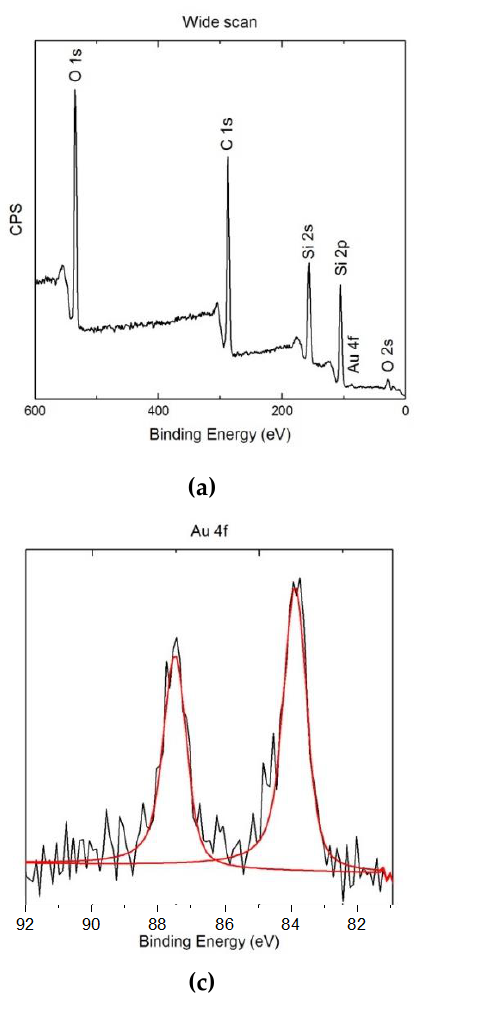
Figure 7. X-ray Photoelectron Spectroscopy (XPS) wide spectra of ME/PDMS/Au ( a ) and ME/PDMS/Pd ( b ) foams. High-resolution Au 4f ( c ) and Pd 3d peaks ( d ) and their deconvolution.